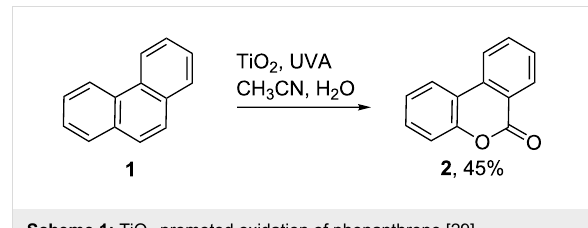
Oxygen acts as the acceptor, picks up electrons from the semi- conductor surface, so yielding superoxide anions that are converted to hydroperoxyl radicals and to hydrogen peroxide on successive reductions and protonations. The ROS generated in these ways oxidize any organic components or pollutants,